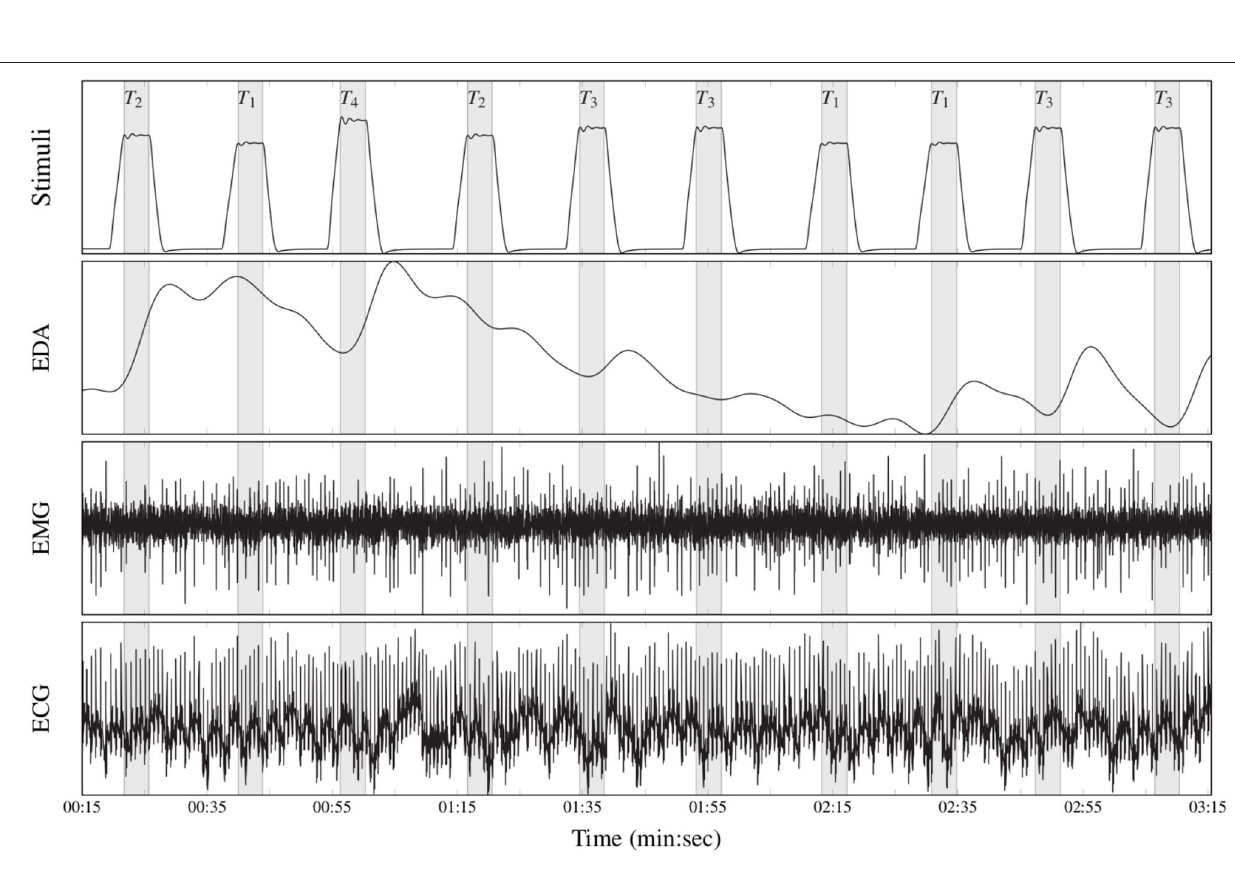
Frontiers in Physiology |